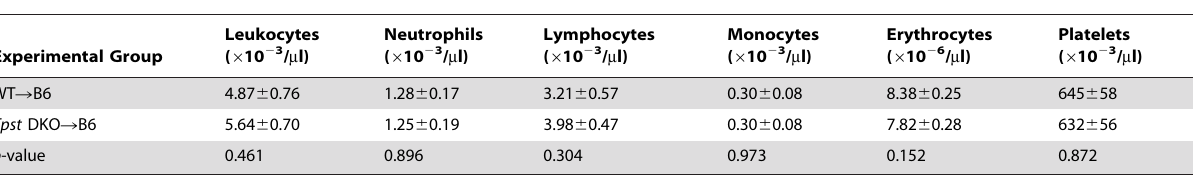
Table 1. Complete blood counts.